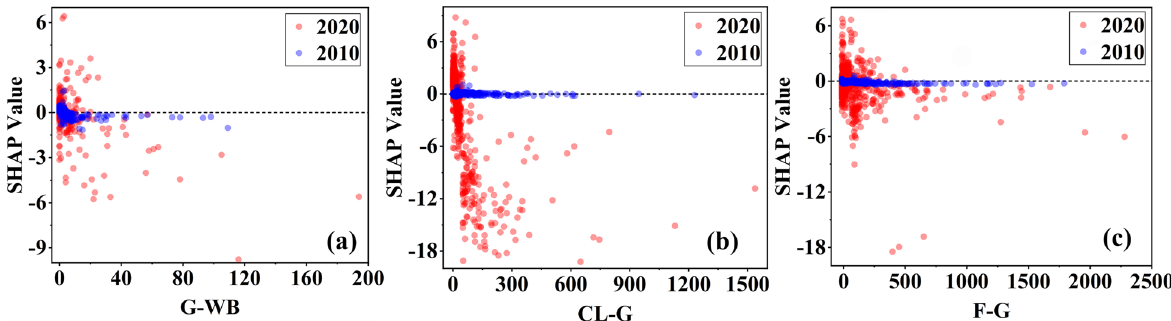
Table 2 The relationship between LCSC and NTL intensity WB‑AS W‑AS G‑AS